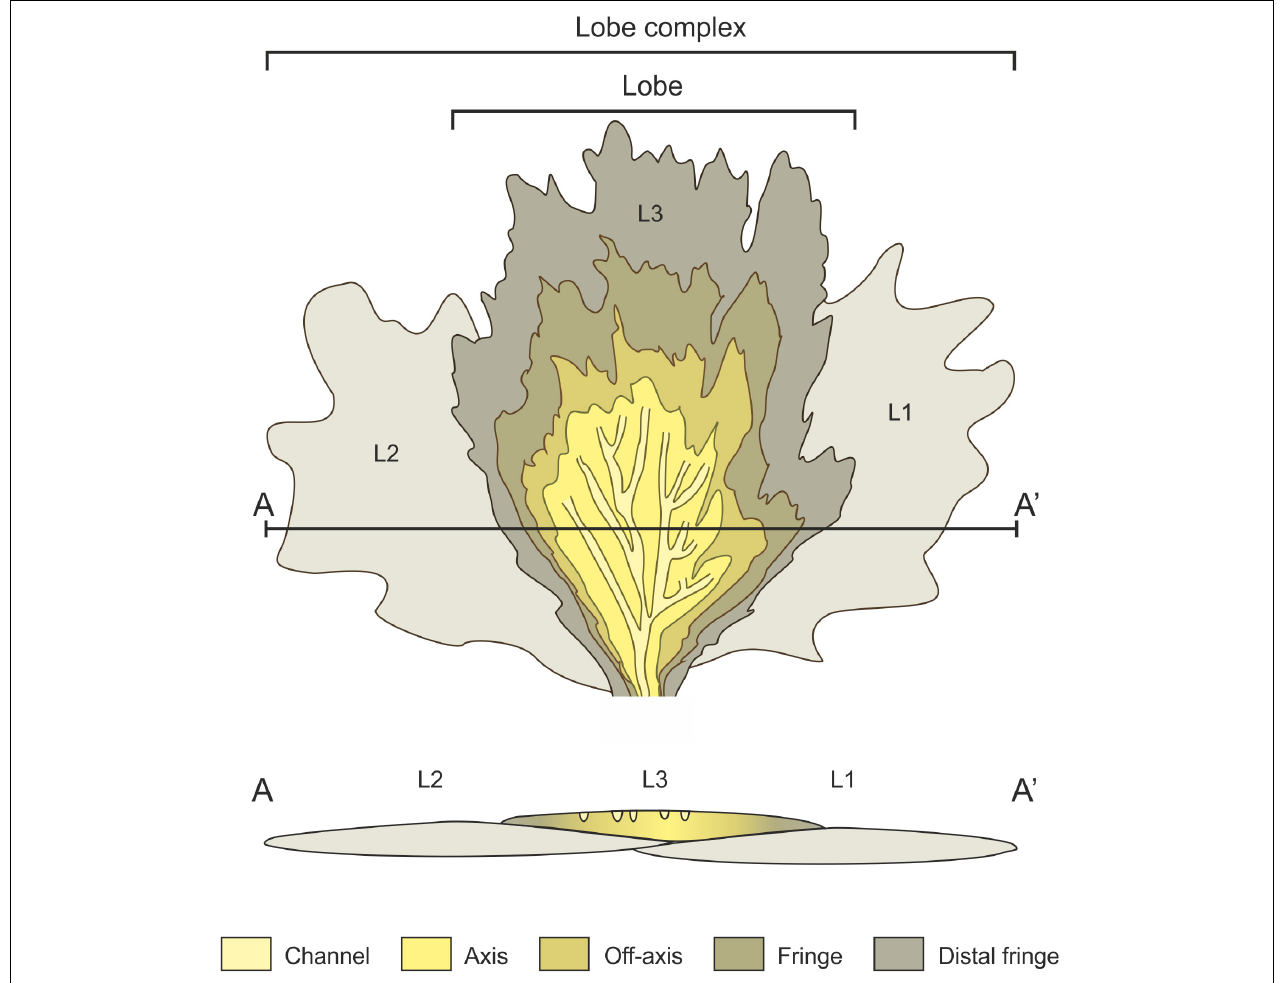
FIGURE 4 | Cartoon indicating the various sub-environments in a lobe, and the stacking of lobes to form a lobe